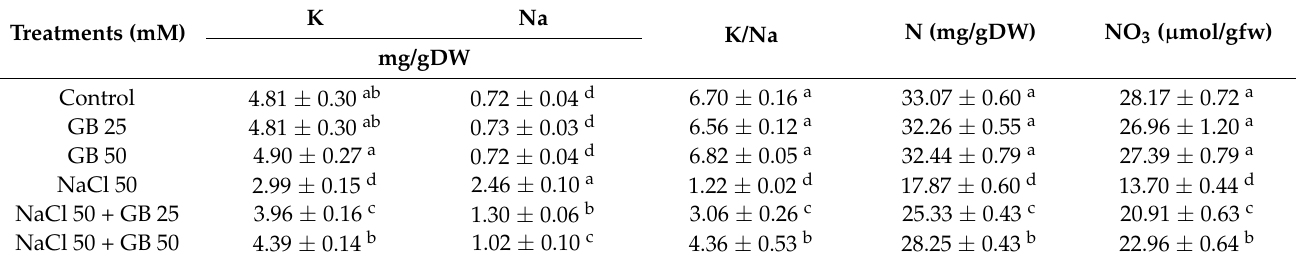
Table 2. Effect of glycine betaine (GB, 0, and 50 mM) on the leaf concentrations of K and Na, the K/Na ratio, and the leaf concentrations of N and NO 3 of the stevia plant under NaCl (0, 25, and 50 mM) treatment.